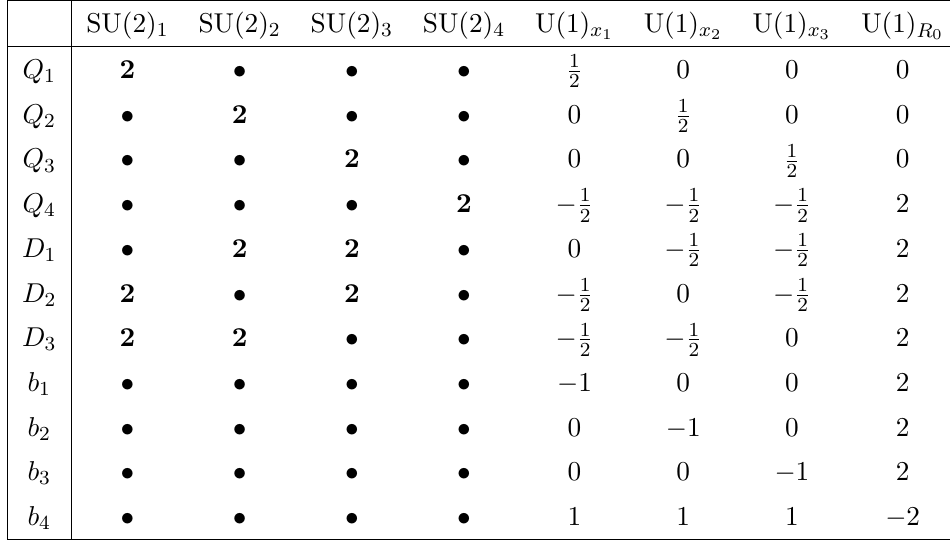
Table 1 . The representations of the chiral fields under the symmetry groups.